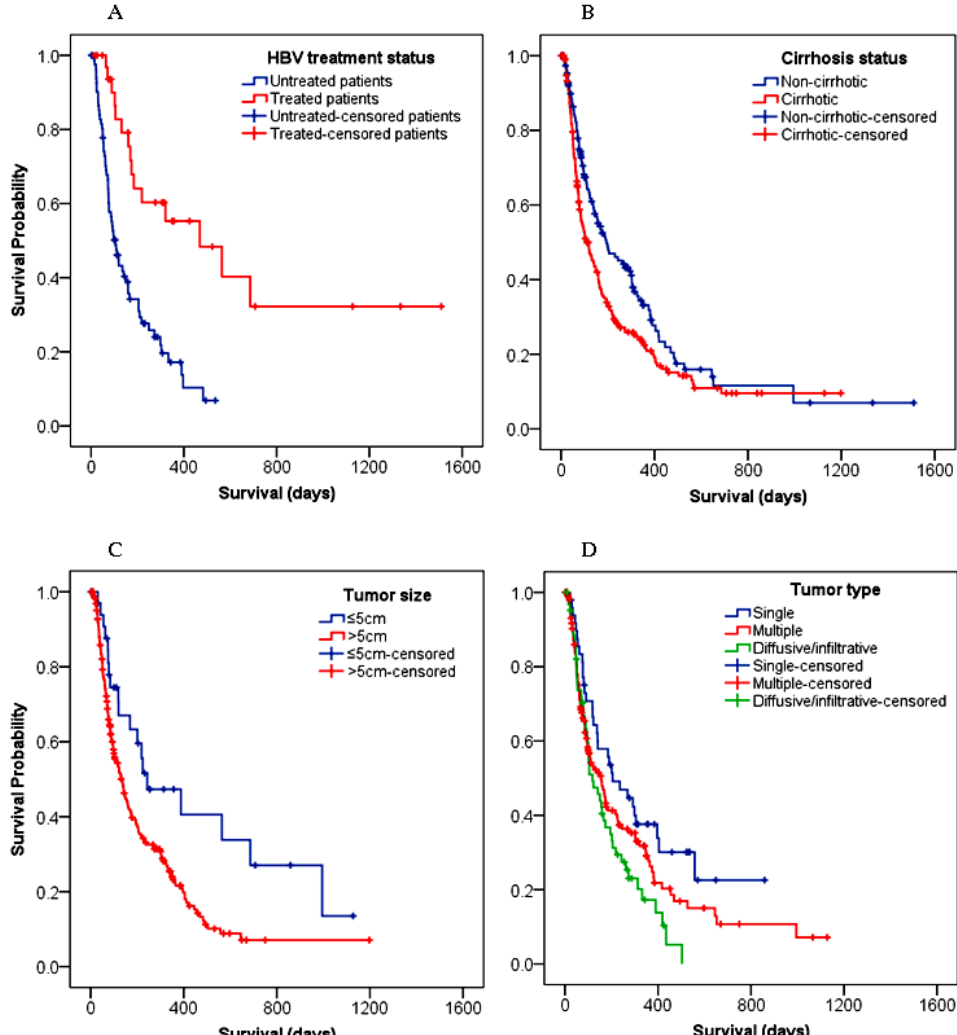
Figure 3. Survival differences among HCC patients: ( A ) HBV treated and untreated; ( B ) cirrhotic versus non-cirrhotic; ( C ) with tumor sizes of ≤5 cm versus >5 cm; ( D ) with different tumor types. Censored patients are indicated as the mark “+” and represent patients who were lost during follow- up or alive at the end of the study. HBV, hepatitis B virus.